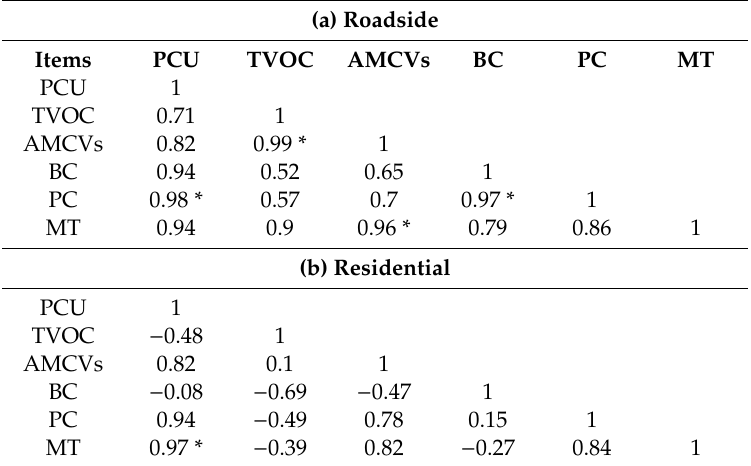
Table S1: Method detection limit of analyzed VOC species (ppbv), Table S2: Ambient monitoring comparison values (AMCVs) for long-term